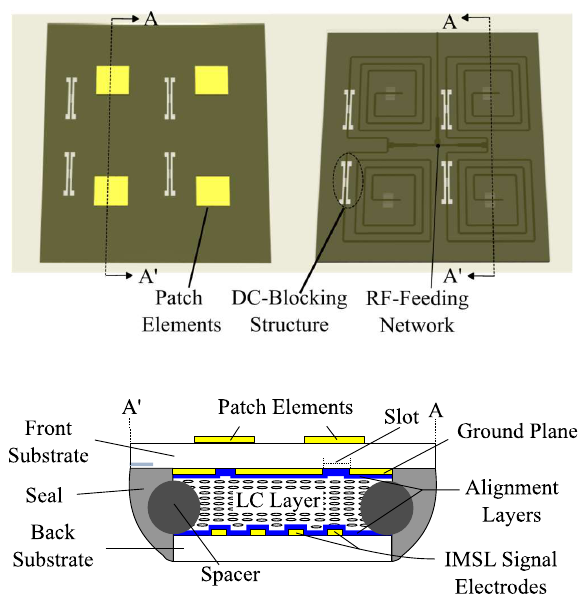
Figure 32. Schematic of the 2 × 2 microstrip patch array with an element spacing of 0.65 λ 0 × 0.65 λ 0 [170,175]. Front view with the four patch elements ( above, left ). Back view with the spiraled IMSL lines ( above, right ). Cross-section of the array ( below ).